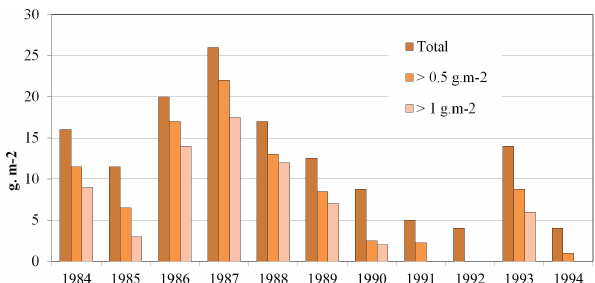
Table 1. Mineral dust deposition to the ocean.